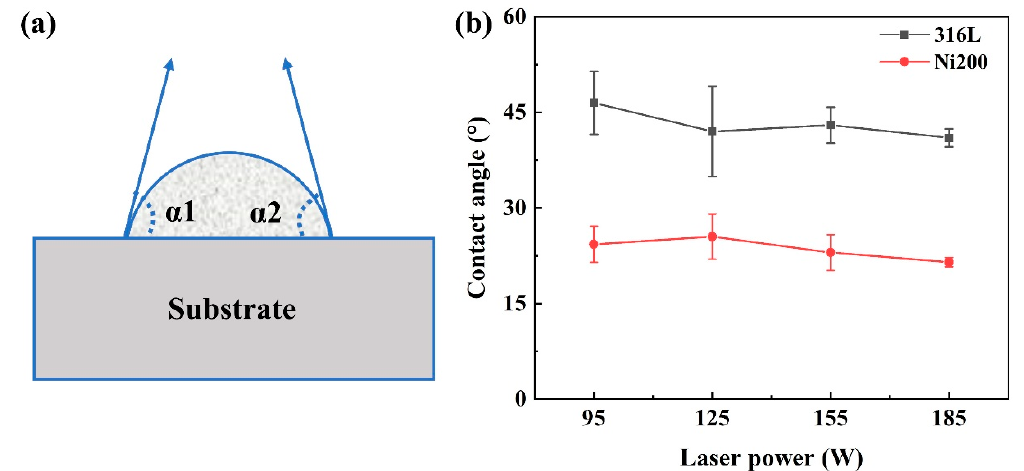
Figure 8. ( a ) Schematic diagram of the contact angle. ( b ) Contact angle of the single tracks formed on 316L and Ni200 substrates.